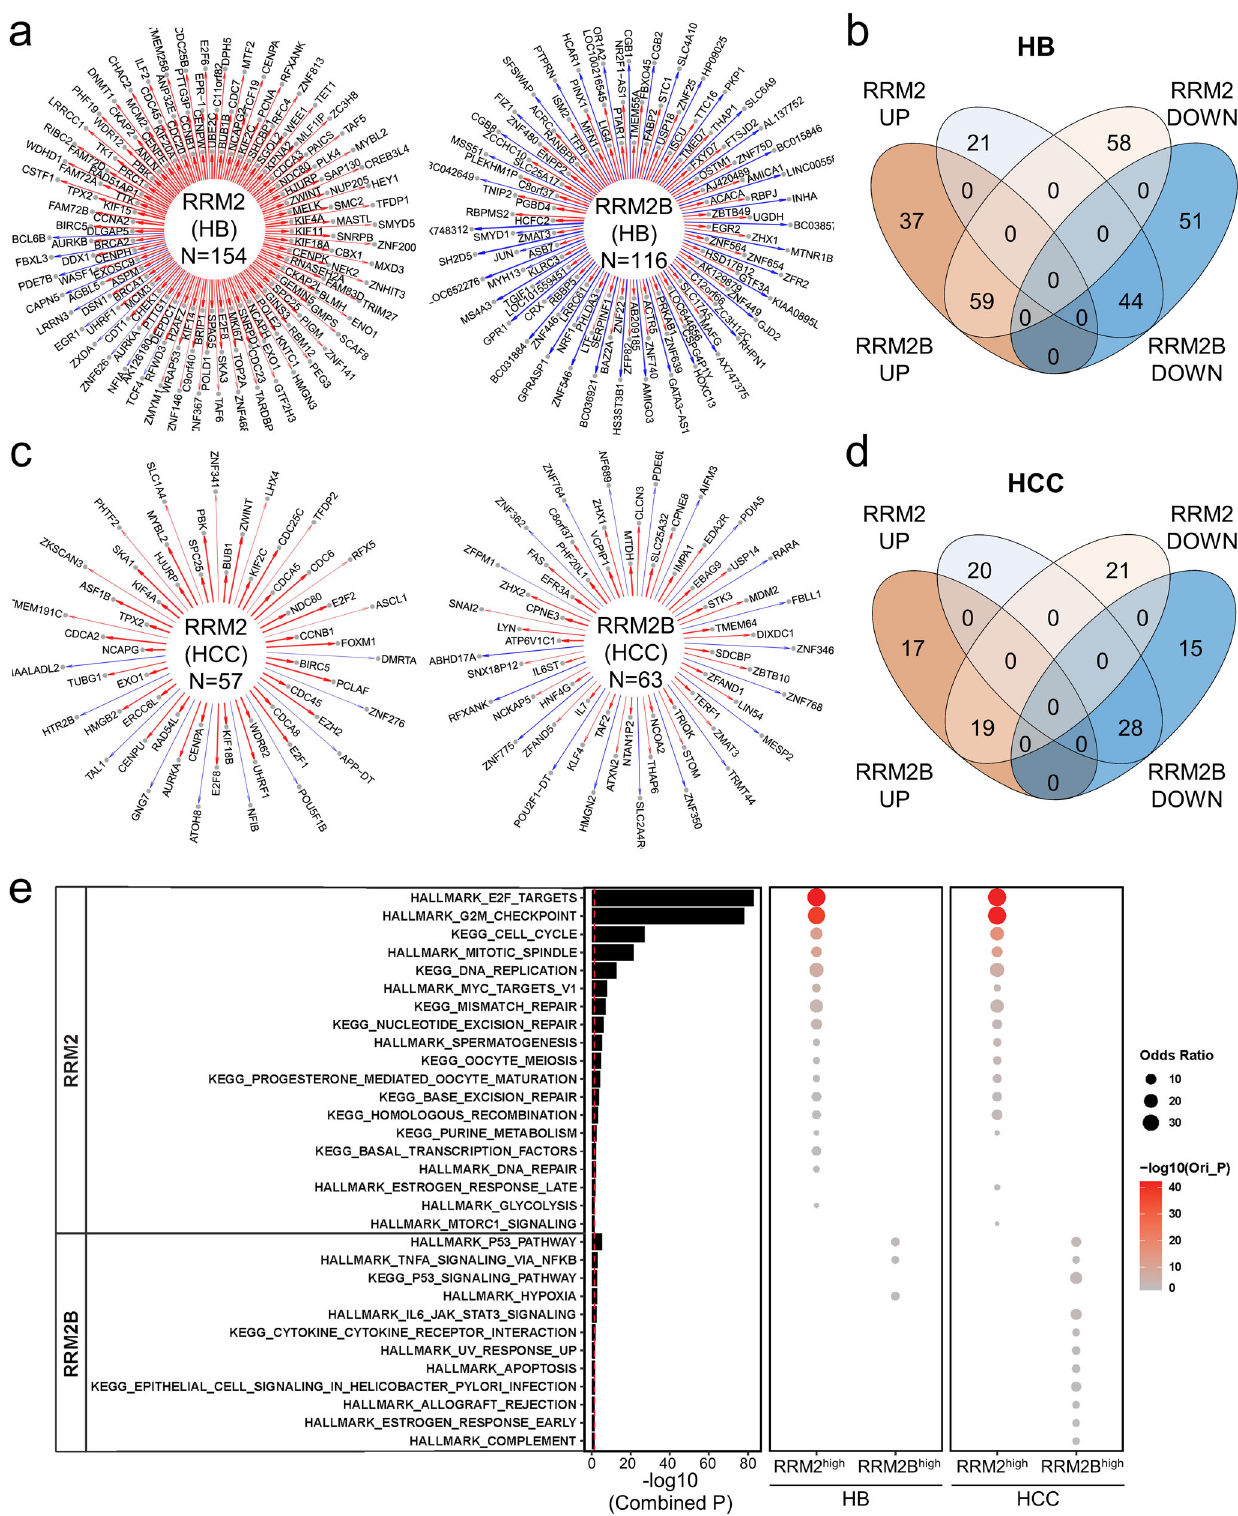
Fig. 2 NetBID identi fi ed distinct hub genes and associated signaling pathways of RRM2 and RRM2B in HB and HCC patient tumors. a The RRM2 and RRM2B networks in 88 HB patient tumors inferred by SJARACNe. Edge width corresponds to the correlation strength measured by mutual information. Red and blue edges indicate positive and negative correlations between the expression of RRM2 or RRM2B and their individual hub genes. b Venn plot showing the overlap of the four indicated RRM2 and RRM2B hub gene lists identi fi ed in HB patient tumors. c The RRM2 and RRM2B networks in 374 HCC patient tumors similarly de fi ned as in ( a ). d Venn plot showing the overlap of the four indicated RRM2 and RRM2B hub gene lists identi fi ed in HCC patient tumors. e Gene set enrichment analysisofHALLMARK and KEGGgenesetsofthe 4 hub genelists using Fisher ’ s Exact Test. The sizeand color intensity indicatethe oddsratioand statistical signi fi cance, respectively. The P values of the bar plot were combined from HB and HCC primary patient cohorts using the Stouffer